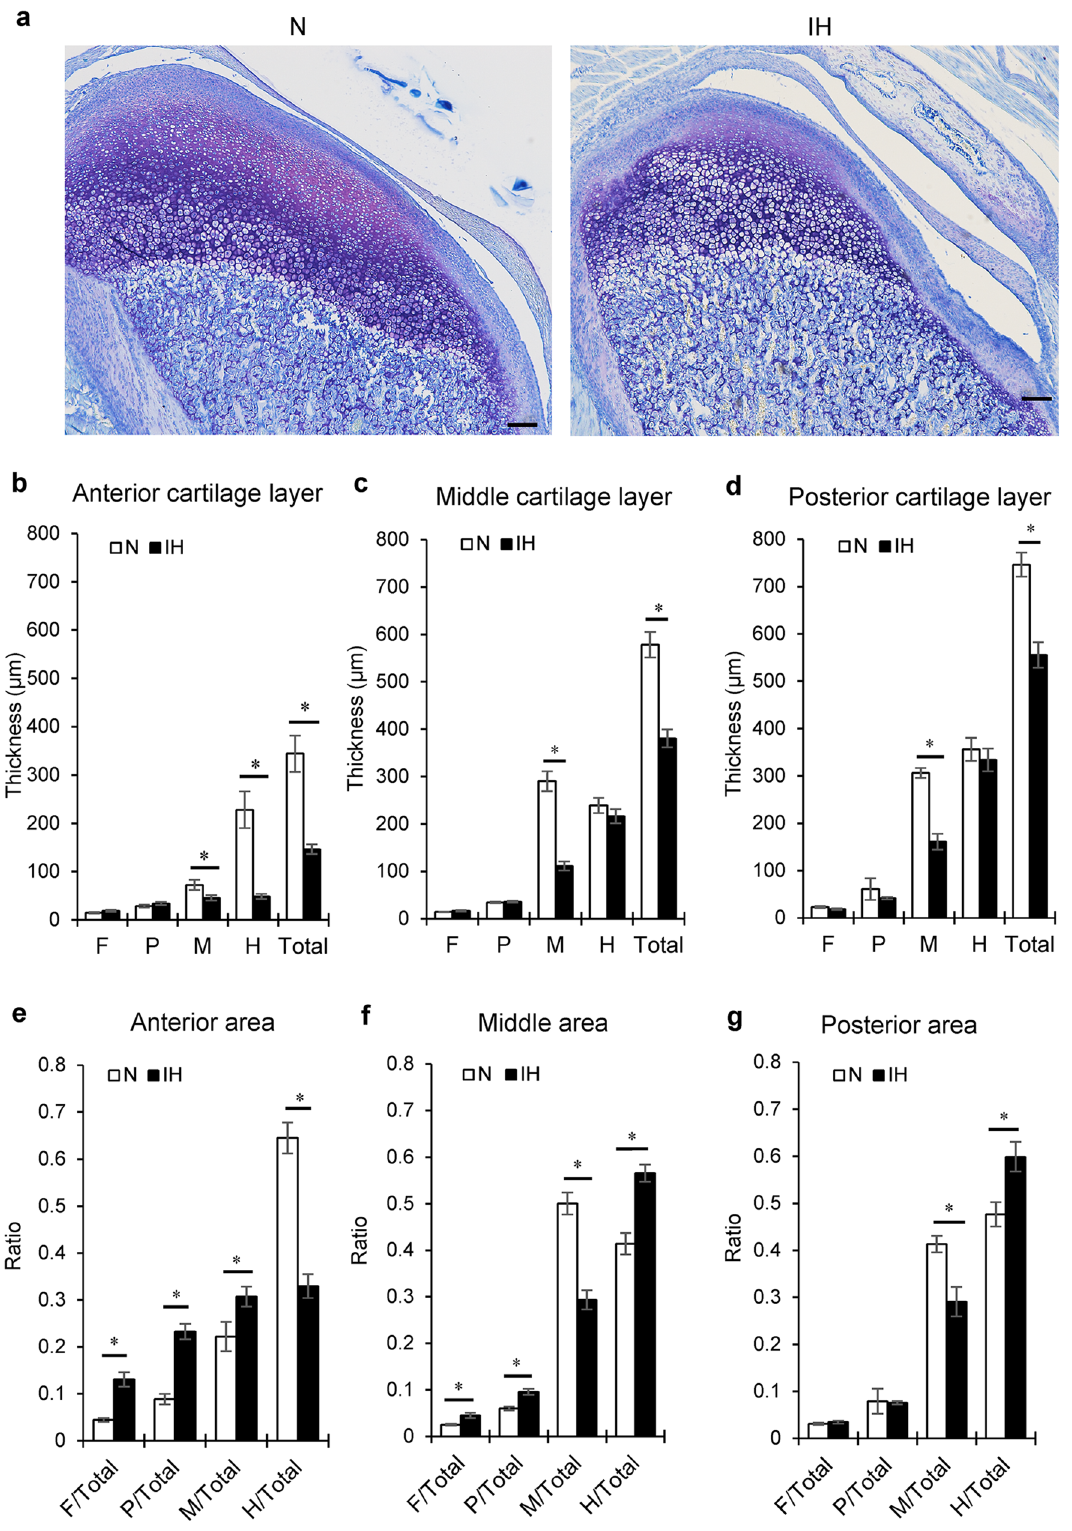
Figure 5. Histological changes in mandibular condylar cartilage of IH rats. ( a ) Representative images of toluidine blue-stained sagittal sections of mandibular condyle from the N and IH groups. Thickness of each cartilage layer of anterior ( b ), middle ( c ), and posterior ( d ) parts in mandibular condyle. Ratios of each cartilage layer to total cartilage thickness shown in panels ( e – g ). F fibrous layer, P proliferating layer, M maturative layer, H hypertrophic layer. Scale bar = 100 μm. Data are mean ± SEM for each group. * P <